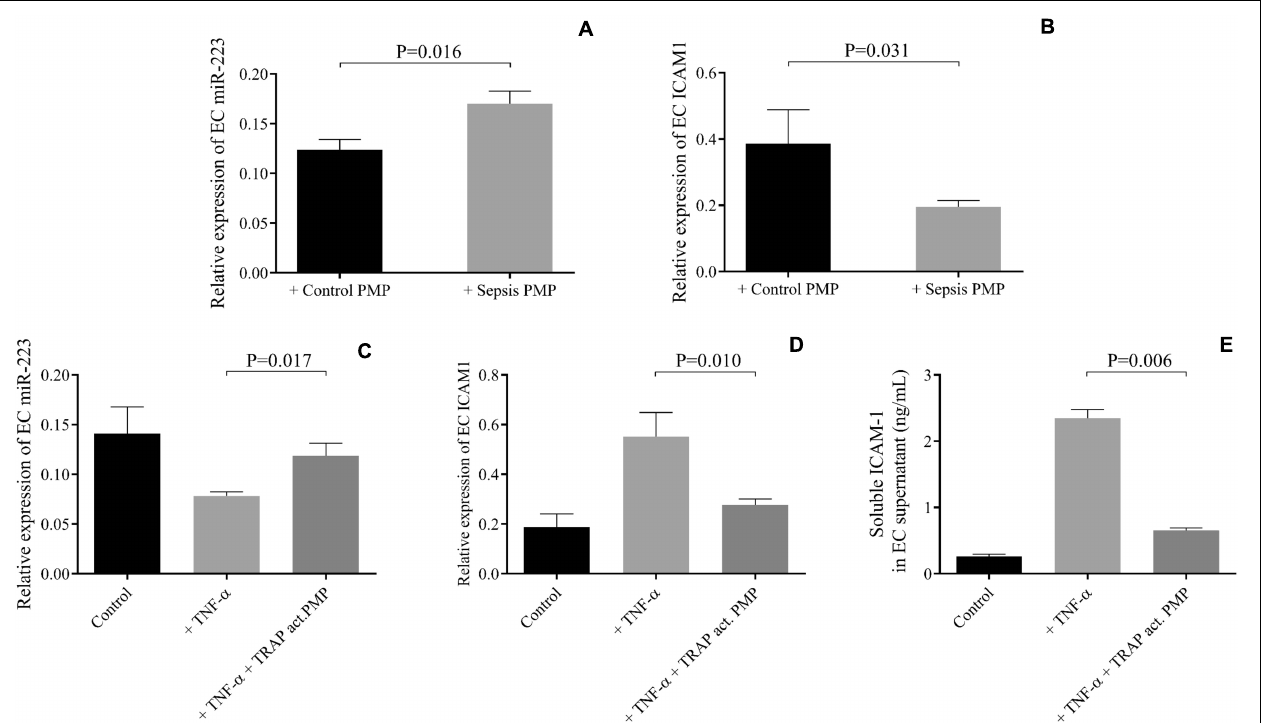
FIGURE 4 | PMPs carrying elevated miR-223 repressed ICAM1 levels in HCAECs under septic conditions. Elevated miR-223 (A) and reduced intercellular adhesion molecule 1 (ICAM1) expression were detected in septic platelet-derived microparticle (PMP) stimulated endothelial cells (EC) after 24 h (gray columns) vs. HCAECs with control PMP (black columns) (B) . TNF- α alone (light gray columns) resulted in lower miR-223 and higher ICAM1 mRNA and protein levels. On the other hand, in the presence of thrombin-receptor activating peptide (TRAP) activated PMP samples (dark gray columns), upregulated miR-223 (C) and reduced ICAM1 mRNA (D) and protein levels (E) were found. Mean ± SEM was depicted ( n = 7–8 samples/group). Mann-Whitney U -test or unpaired t -test was performed for